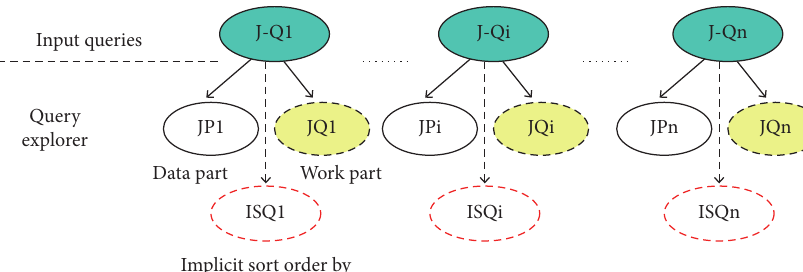
Figure 9: The Query Explorer for multiple multiway join queries.